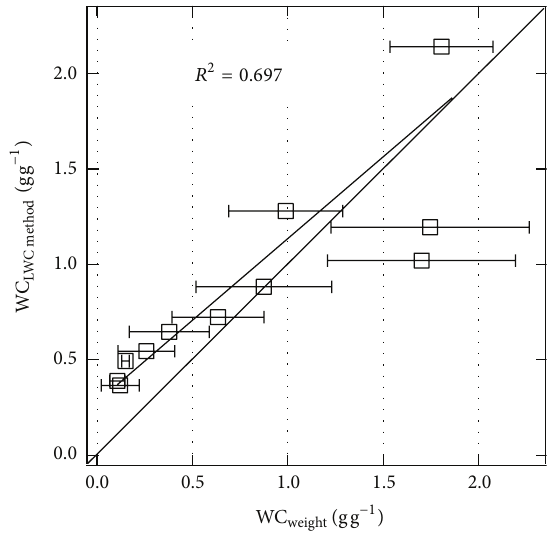
Figure 3: The relationship between the water content of leaf litter samples obtained using the LWC method (WC gravimetric water content (WC represent the standard deviation.